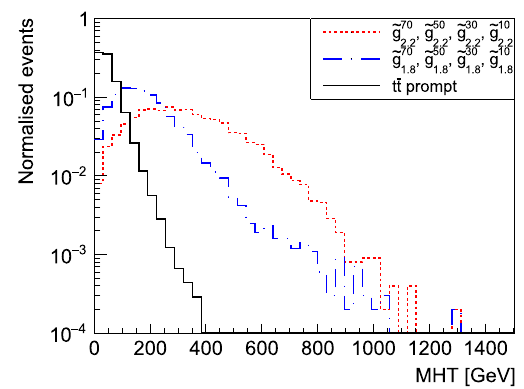
Fig. 75 Missing transverse hadronic energy MHT in the gluino ˜ g case